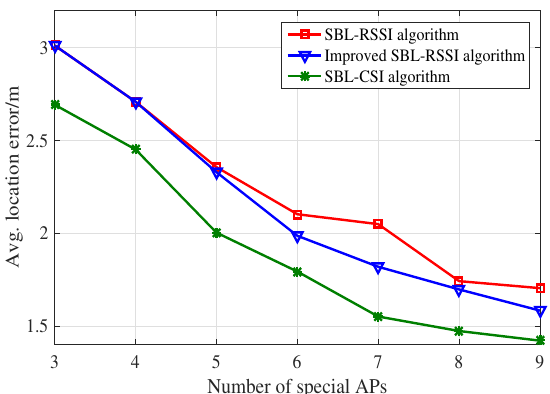
Figure 10. Average location error in the SBL-RSSI algorithm, the SBL-RSSI algorithm with improved Kendall’s Tau and the SBL-CSI